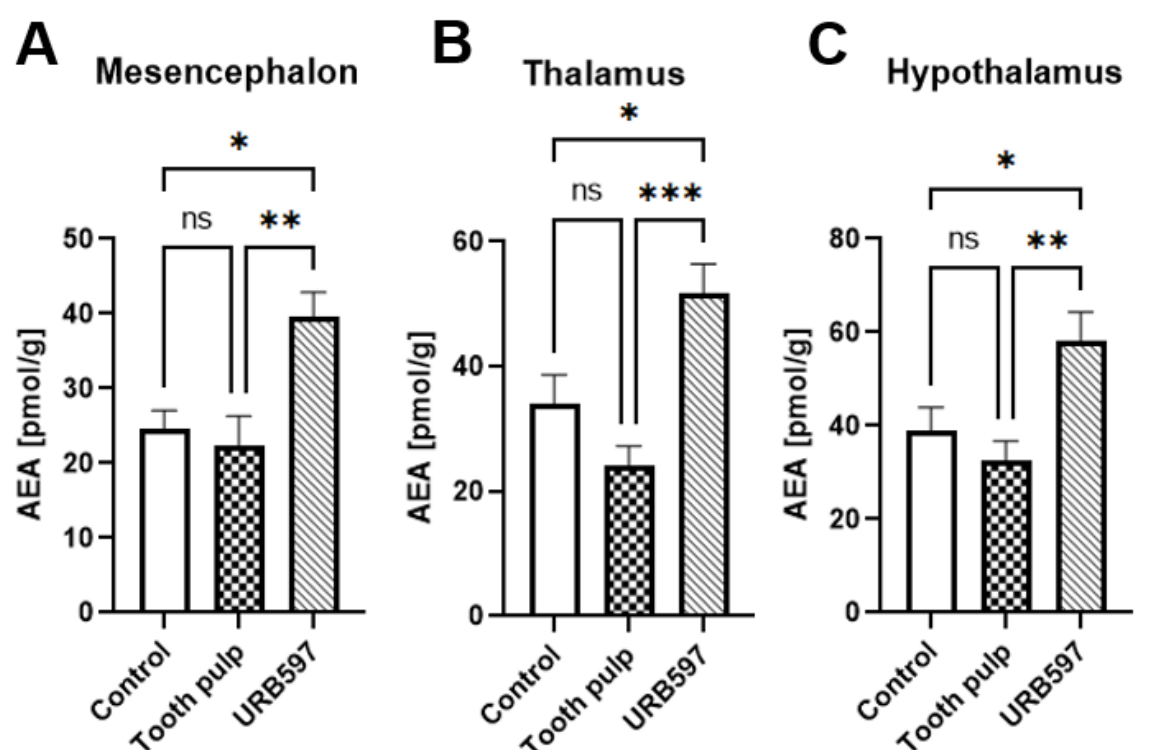
Figure 8. 2-AG concentration in rats in controls and after tooth pulp and URB597 treatment. The data represent mean ± SEM of 6 rats per group. Statistical significance was assessed using one-way ANOVA and a post hoc multiple comparison Tukey test. Asterisks denote significance level (** p < 0.01, ns — not statistically significant).